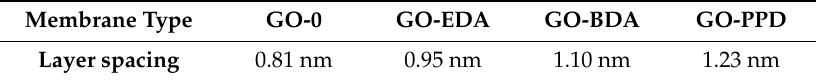
Table 2. Layer spacing of graphene oxide